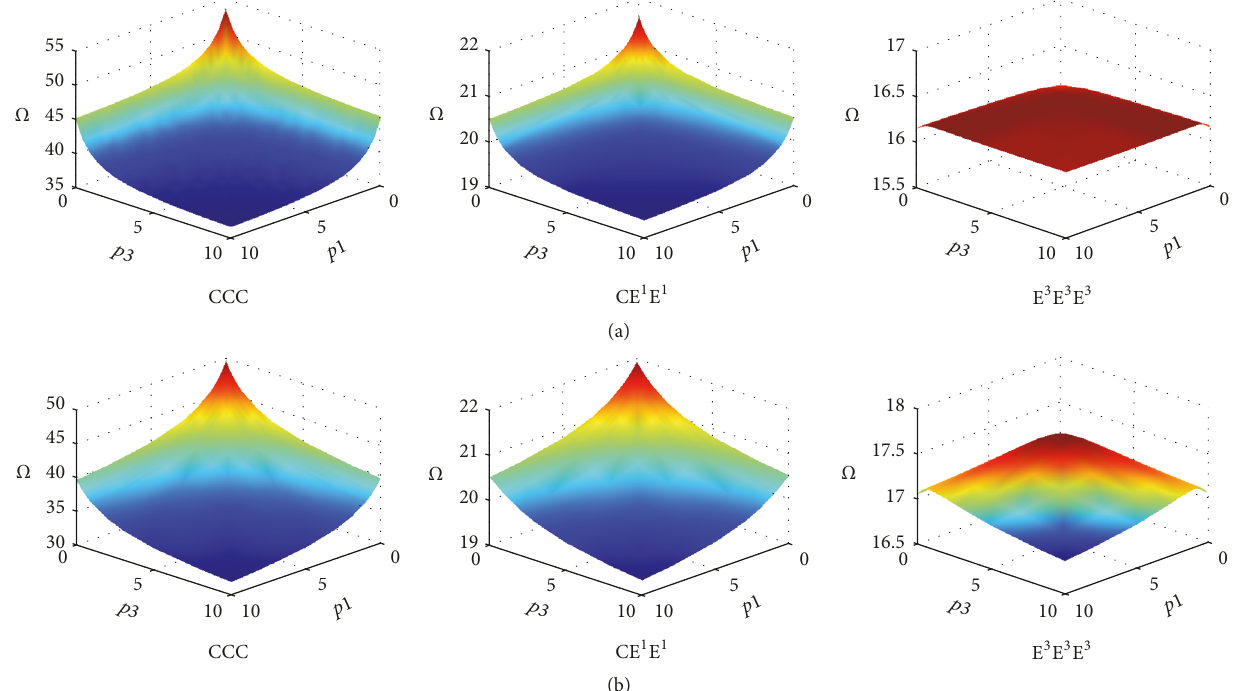
Figure 9: Variations of fundamental frequency parameter Ω of Type 1 circular sector plate against different power-law exponents: (a) Type 1-1 (1-2-1); (b) Type 1-2